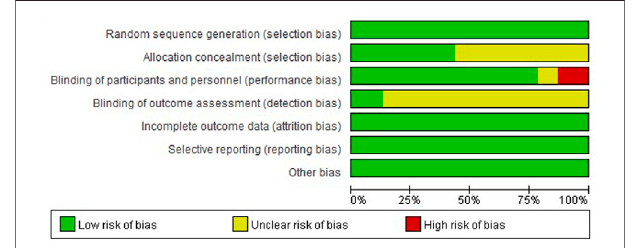
FIGURE 2 | Risk of bias graph: review authors ’ judgements about each risk of bias item presented as percentages across all included studies.